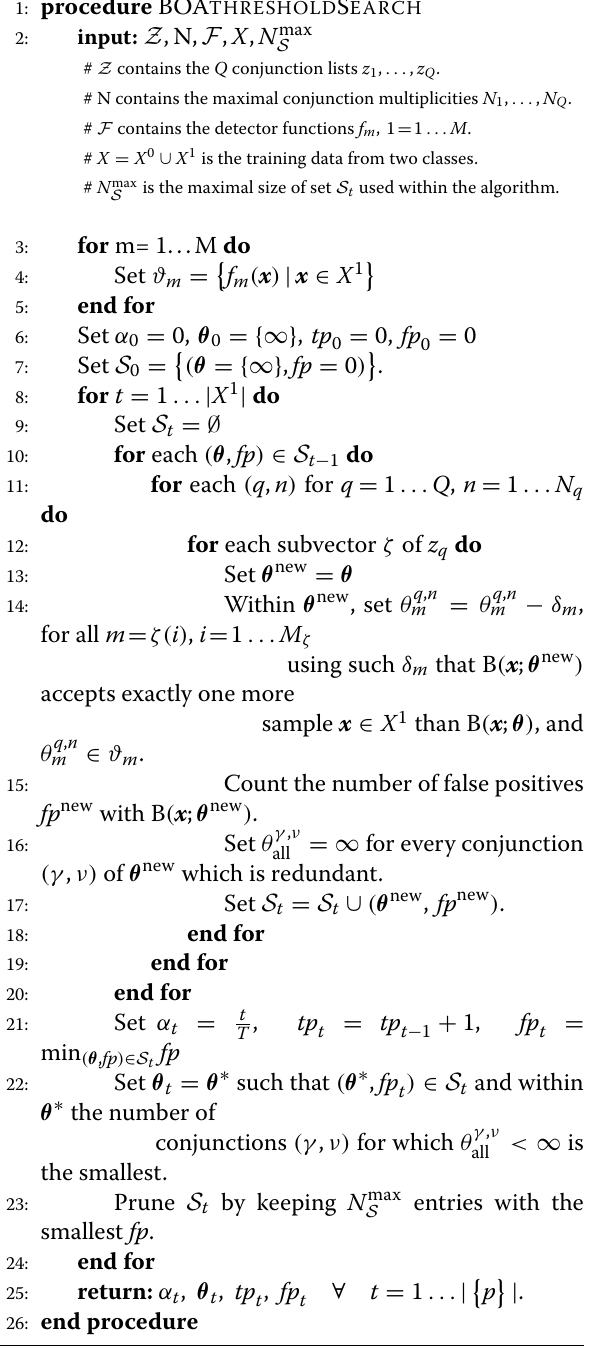
Algorithm 1 An algorithm to find thresholds for a